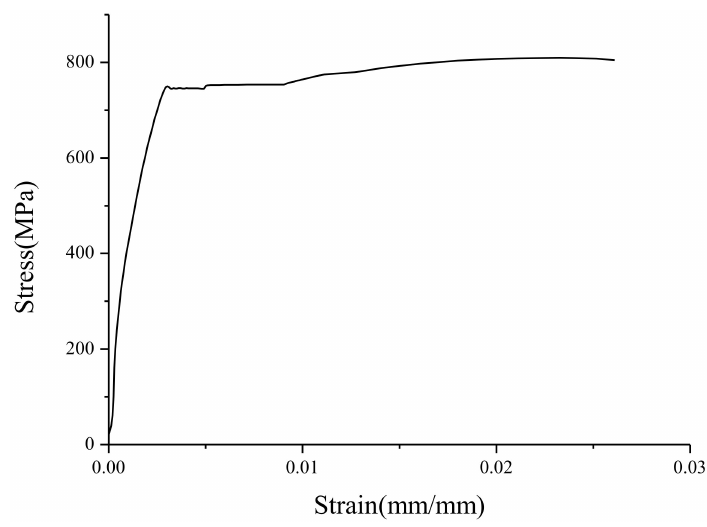
Figure 2. Stress-strain curve of the BS700 high-strength steel TS1 specimen.